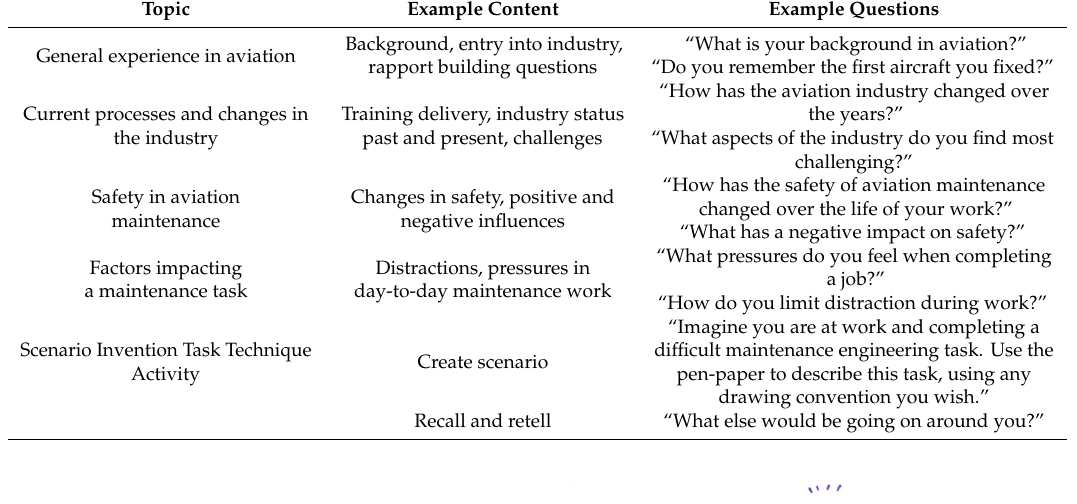
Table 1. Overview of the interview protocol.